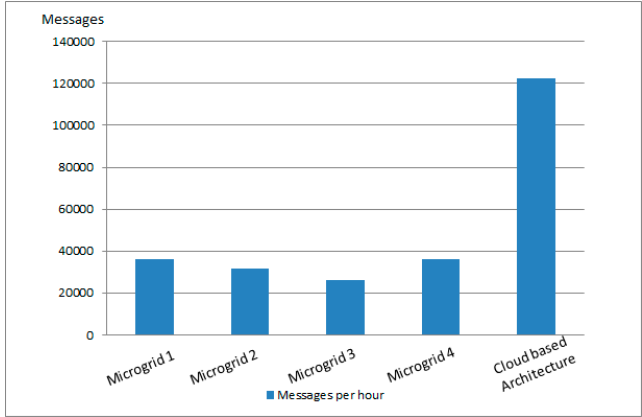
Figure 14. Number of messages sent during one hour by smart meters associated with prosumers.